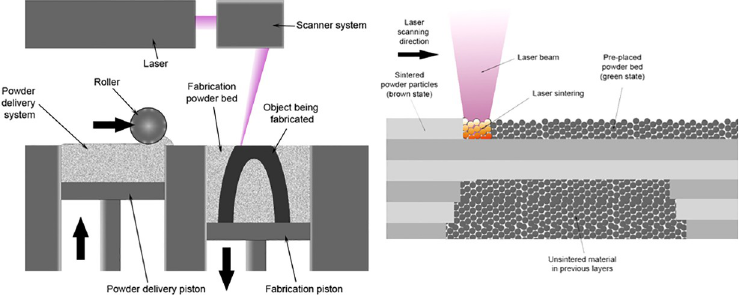
Fig 5. Selective laser sintering process. Schematic representation of the selective laser sintering process. Source: Materialgeeza /Wikimedia commons.